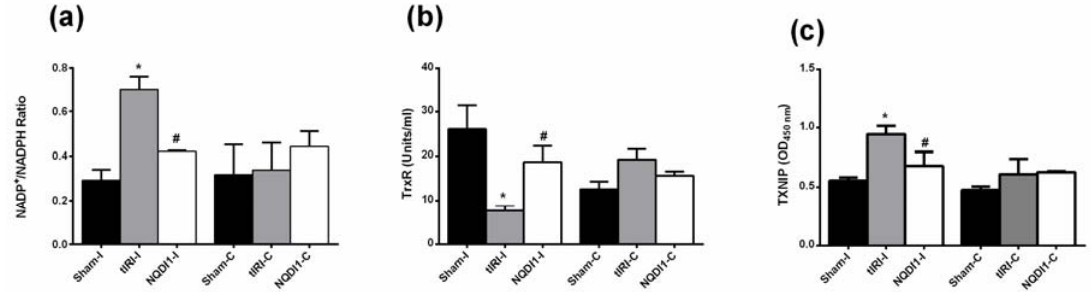
Figure 6. NQDI-1 regulates the expression of the Trx system. In the ipsilateral testes of tIRI-subjected rats, elevated levels of ( a ) NADP + / NADH ratio and ( b ) TXNIP were measured by a colorimetric assay and ELISA, respectively, however, Low ( c ) TrxR activity was measured using a kinetic assay in comparison to the sham group. Treatment with NQDI-1 reverted the levels of NADP + / NADH ratio, TXNIP and TrxR to sham levels. Contralateral testes showed no significant difference between the three animal groups ( p -value > 0.05). NQDI-1 (10 mg / kg) was i.p. injected 30 min post ischemia. Data are presented as mean ± SD ( n = 6 / group). * tIRI compared to sham and # NQDI-1 compared to tIRI. I = Ipsilateral and C = Contralateral.